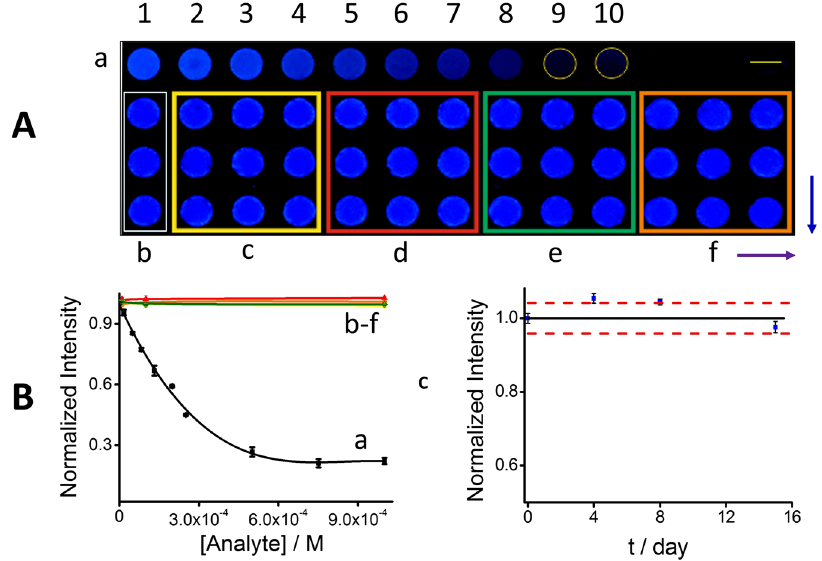
Figure 3. GQDs-modified paper sensing platform. ( A ) Picture of GQDs-modified nitrocellulose paper under UV light. (a) Fluorescence quenching at different concentrations of quercetin: 0 (0.01 M PBS buffer), 1.66 × 10 − 5 , 4.98 × 10 − 5 , 8.30 × 10 − 5 , 1.33 × 10 − 4 , 1.99 × 10 − 4 , 2.51 × 10 − 4 , 5.01 × 10 − 4 , 7.52 × 10 − 4 , 1.25 × 10 − 3 , 1.50 × 10 − 3 M (from 1 to 10), respectively. Selectivity testing: (b) 0.01 M PBS buffer and increasing concentrations (per each square as indicated by the purple arrow) of (c) phenol, (d), catechol (e) hydroquinone and (f) 4-aminophenol, 1.00 × 10 − 5 , 1.00 × 10 − 4 and 1.00 × 10 − 3 M, respectively. The blue arrow indicates the same concentration by triplicate. Yellow dotted lines define the sensing area in cases where was difficult to determine, for instance, at a high extent of quenching. Scale bar is 4 cm. ( B ) Corresponding normalized intensity-analyte concentration profile with fluorescent intensity obtained from ( A ). ( C ) Stability testing of the paper-based sensing platform upon time: control chart based on the average intensity for the first day (continuous black line) and following the ± 3 σ criterion (dashed red